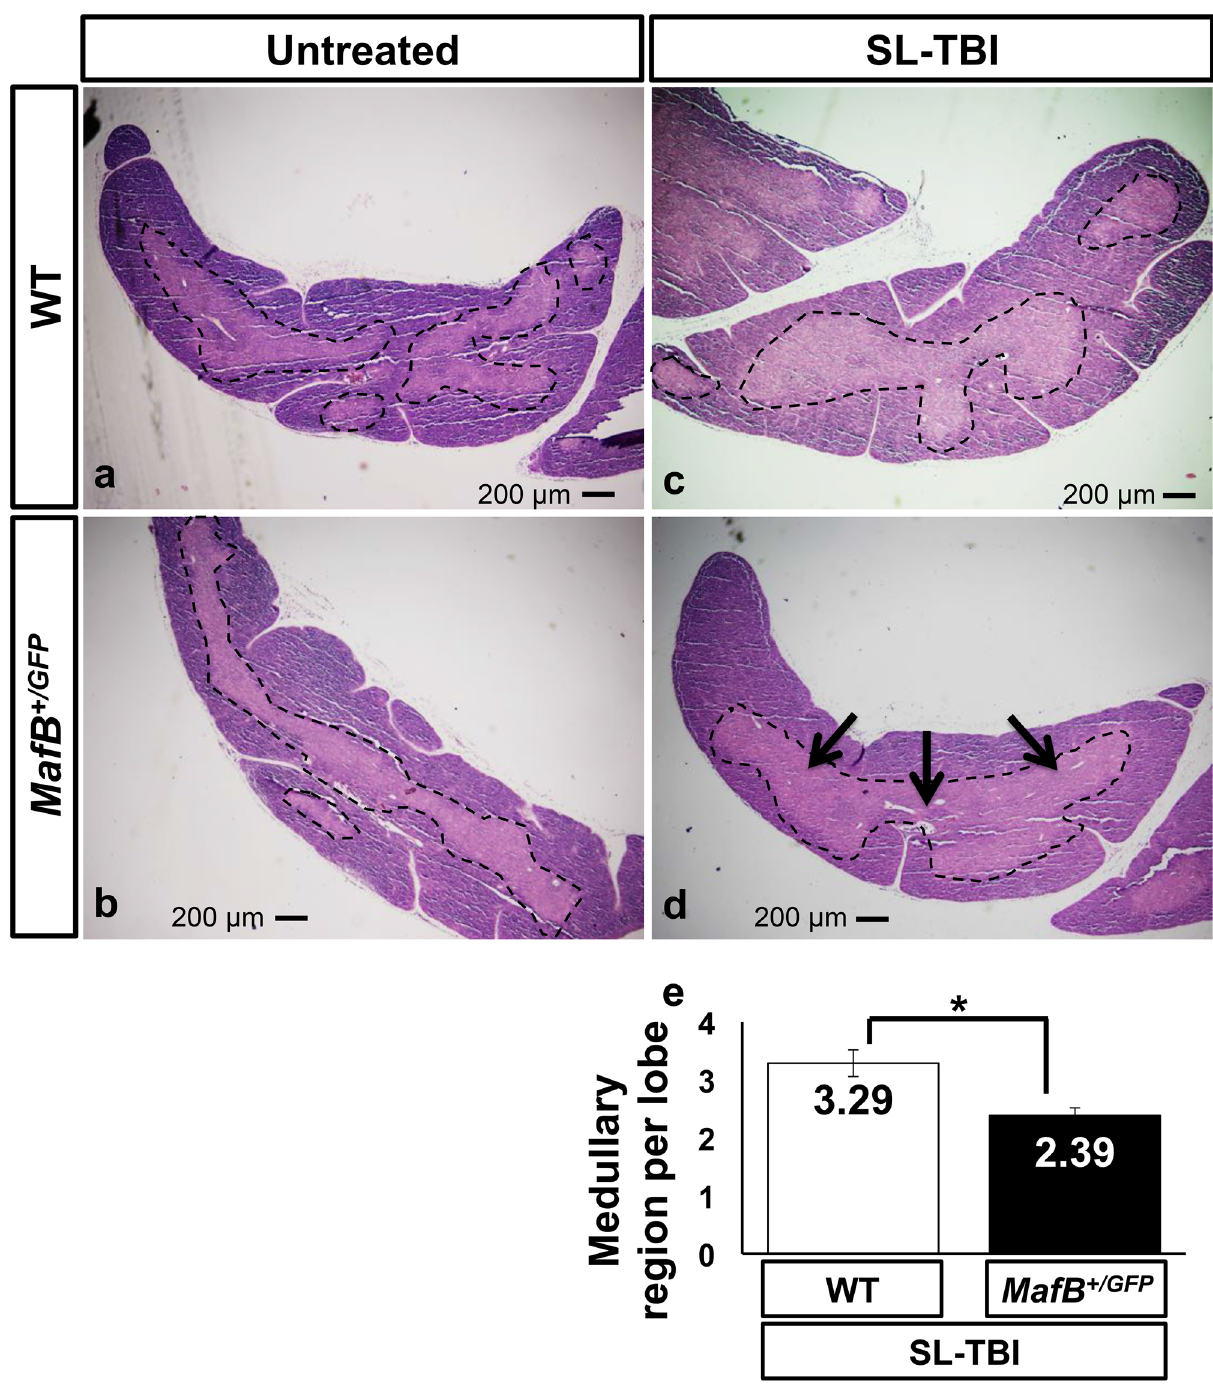
Figure 4. MafB + /GFP mice showed impaired restoration of thymic architecture after SL-TBI. ( a – d ) Hematoxylin and Eosin (H.E.) staining of 9-week-old MafB + /GFP and WT thymi paraffin serial sections (transverse), 28 days after SL-TBI. The borders of medullary region are indicated by black dotted lines. Scale bar: 200 µm. Multiple medullary region were observed in ( a ) untreated WT thymi, ( b ) untreated MafB + /GFP thymi, and ( c ) SL-TBI- treated WT thymi. ( d ) SL-TBI-treated MafB + /GFP thymi showed reduced number of medullary region compared to those of SL-TBI-treated WT littermates. Transverse sections of SL-TBI-treated MafB + /GFP thymi frequently exhibited a single large medulla region (indicated by black arrows), which was rarely observed in SL-TBI-treated WT counterparts. ( e ) Quantification of medullary region per thymic lobe was performed based on H.E.-stained serial sections (approximately 800 sections) from SL-TBI-treated WT and MafB + /GFP thymi. Data in ( e ) are shown as the means ± SD. *P < 0.05 (Student’s t test). All data shown are representative results of 3 independent experiments using adult specimens from different litters (n =